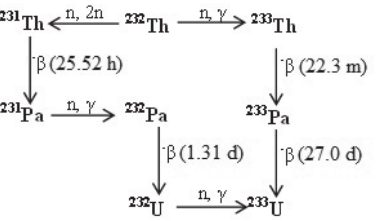
Figure 3. A chain of nuclide transformations starting with tho- rium (Bowman 2007).